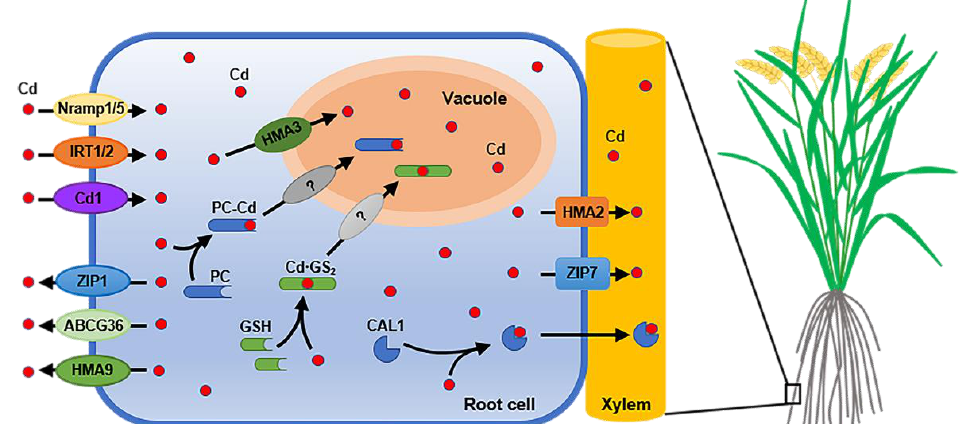
Figure 1. Schematic diagram of Cd uptake, efflux, vacuolar sequestration and loading into xylem in rice root. Cd is absorbed by root cells from soil, which is mediated by OsNramp1 , OsNramp5 , OsIRT1, OsIRT2 and OsCd1 . After entering root cells, Cd is able to be transported into vacuole by OsHMA3 for sequestration. Cd is also to be chelated with PC or GSH and then transported into vacuole in the form of chelates, but the transporters that can transport PC – Cd and Cd·GS 2 into vacuole have not been identified. OsZIP1 , OsHMA9 and OsABCG36 mediate the efflux of Cd, while OsHMA2 , OsZIP7 and CAL1 mediate the loading process of Cd into xylem in rice root. Table 1. Cd uptake, transport and resistance-related genes in